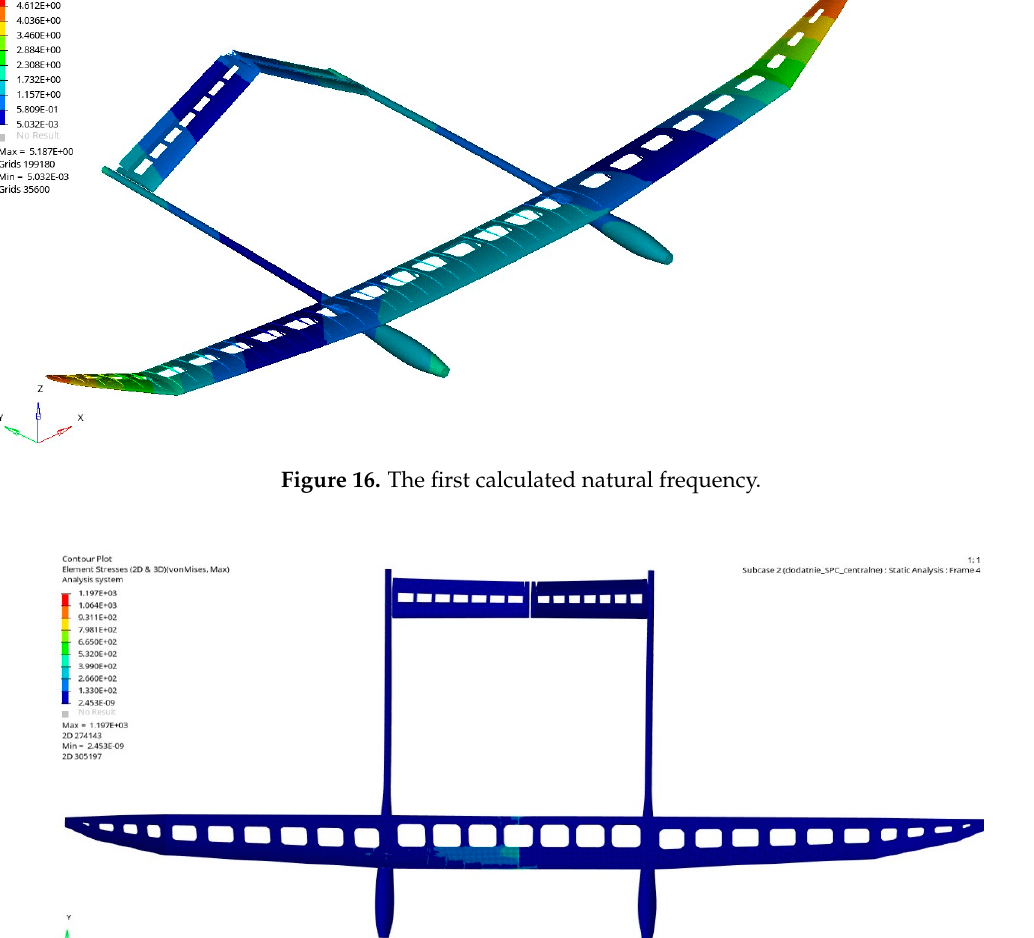
Figure 17. Global stress plot.